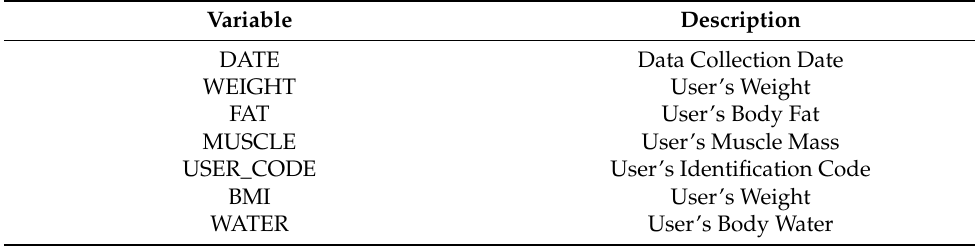
Table 2. Variables and variable descriptions of dataset.